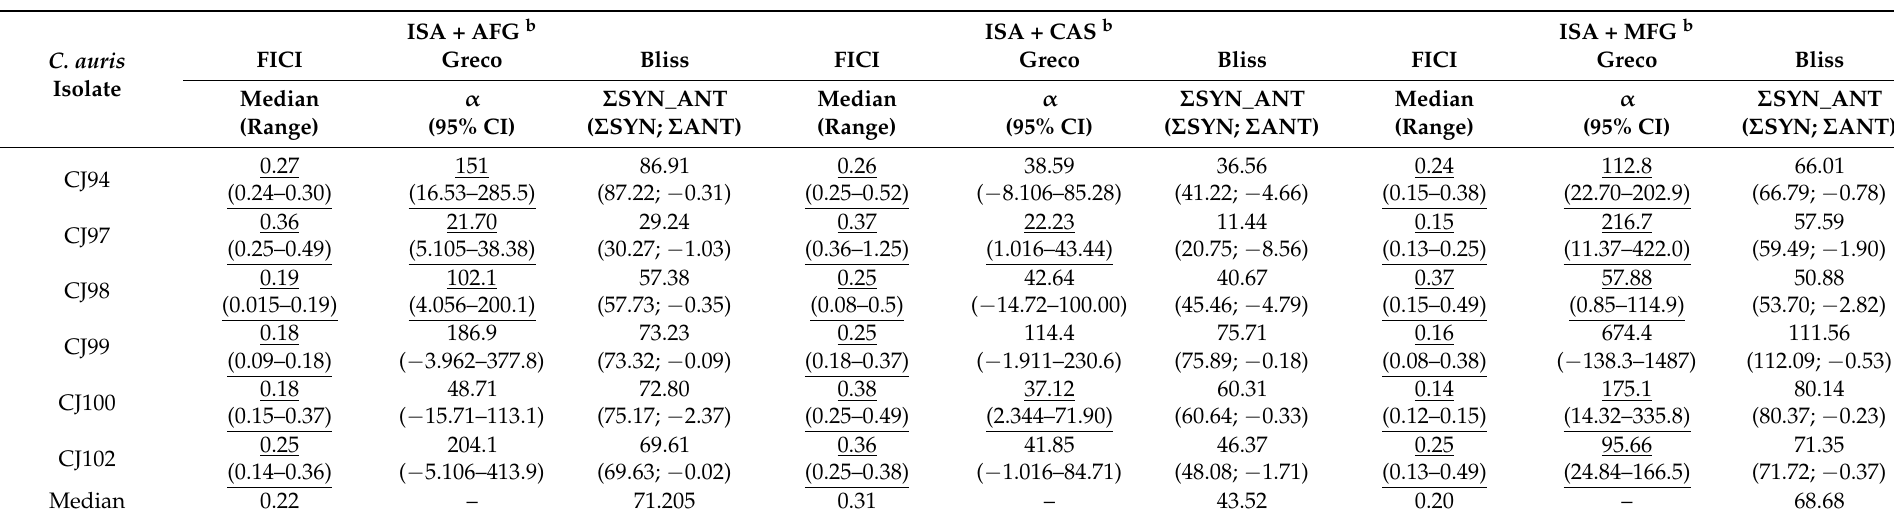
Table 1. Fractional inhibitory concentration index (FICI) and interaction parameters determined by Greco model ( α ) and Bliss model ( Σ SYN_ANT) a .